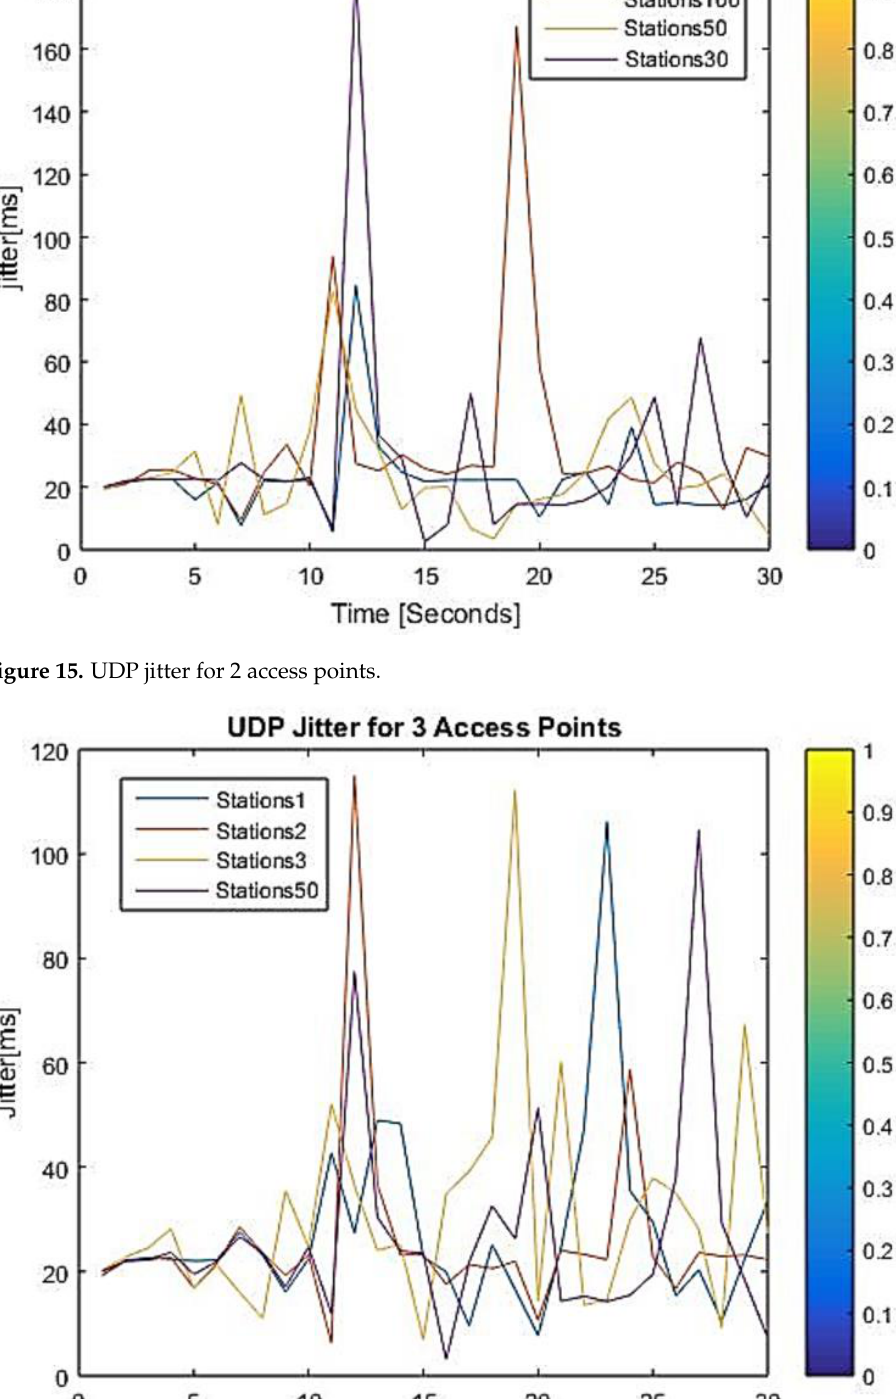
Figure 16. UDP jitter for 3 access points.